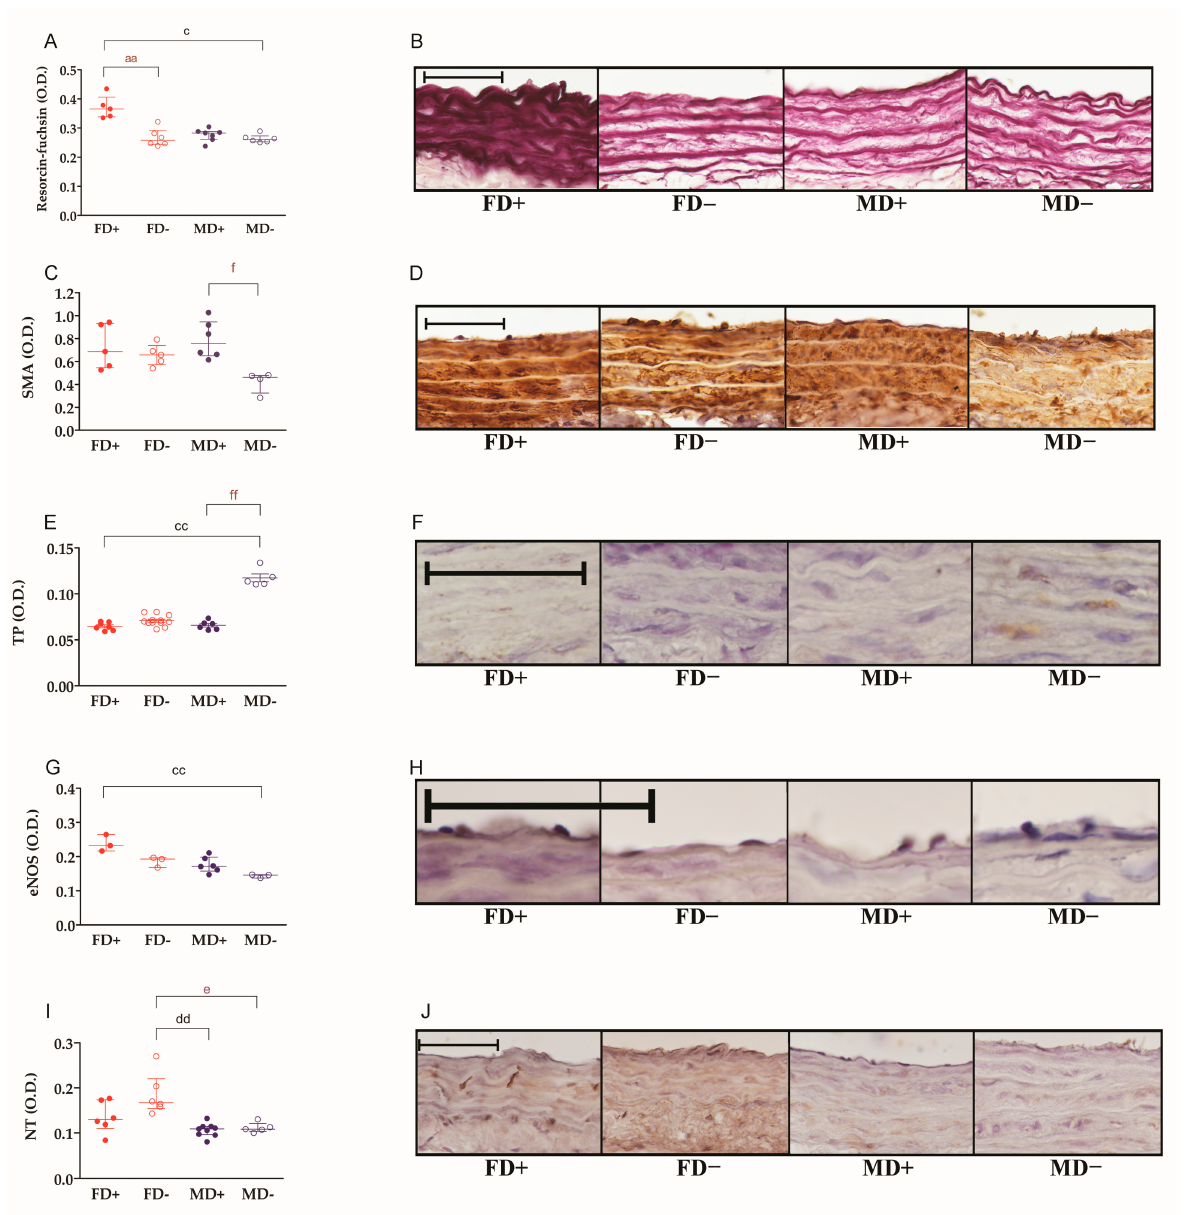
Figure 3. Histological changes of the carotid arteries: ( A ) elastic fiber density of carotid artery segments. Tissue sections were stained by the purple-colored resorcin-fuchsin stain. Vitamin D deficient female and male arteries showed